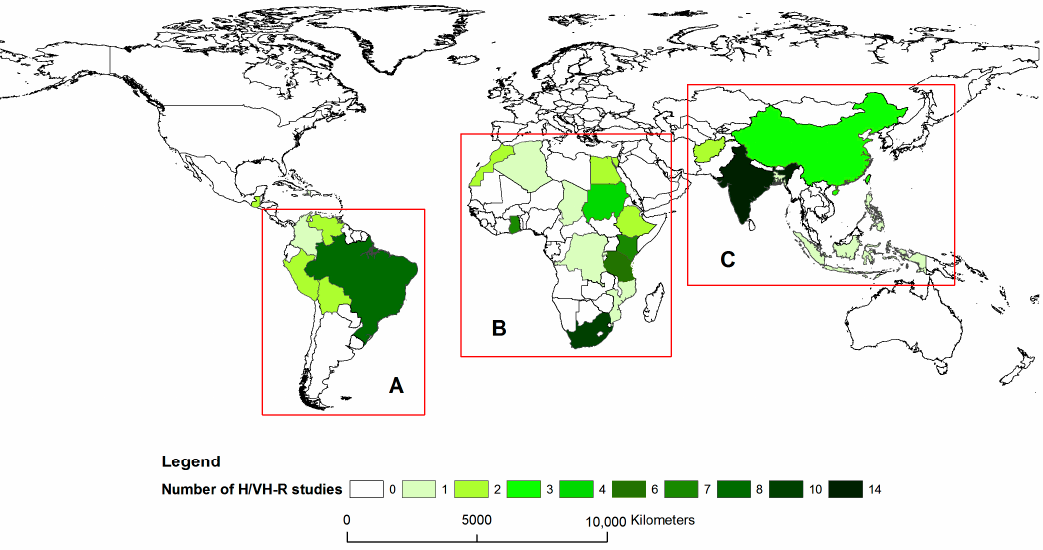
Figure 2. Country level distribution of H/VH-R studies (studies published between 1997–2016).